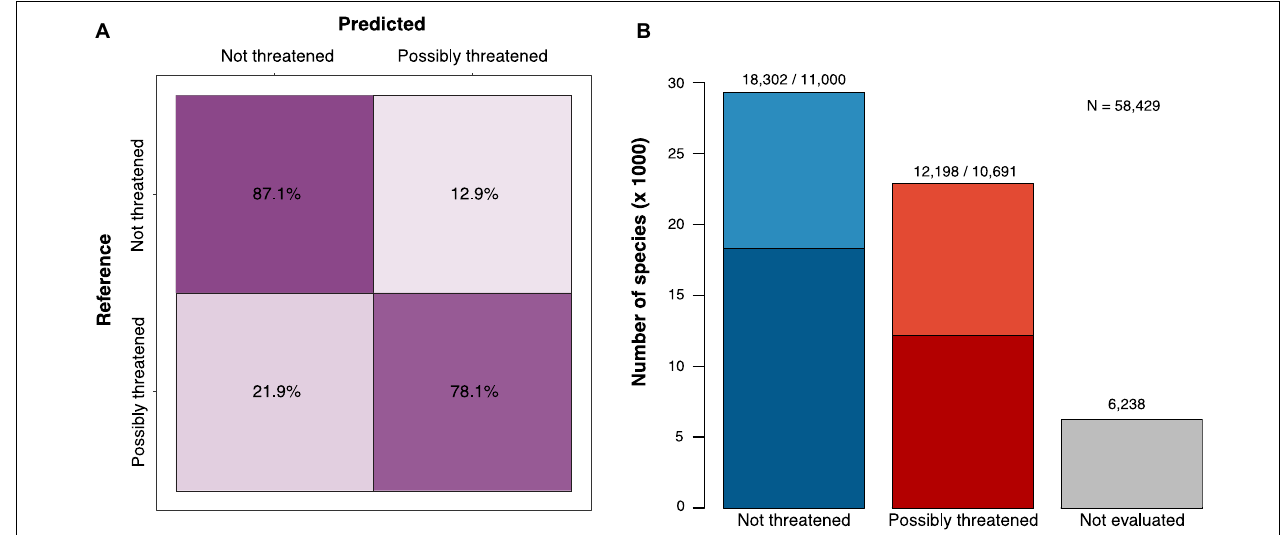
FIGURE 1 | The classification results and performance of a deep learning model trained to identify possibly threatened tree species (binary classification; see Supplementary Figure 1 for the 5-class confusion matrix). (A) Confusion matrix showing the per-class prediction accuracy (cross-validation test sets) and (B) assessment of 58,429 species combining the IUCN RL (darker shades) and our predictions (lighter shades). Of the 52,191 species that could be assessed, 56% were estimated as not threatened and 44% as possibly